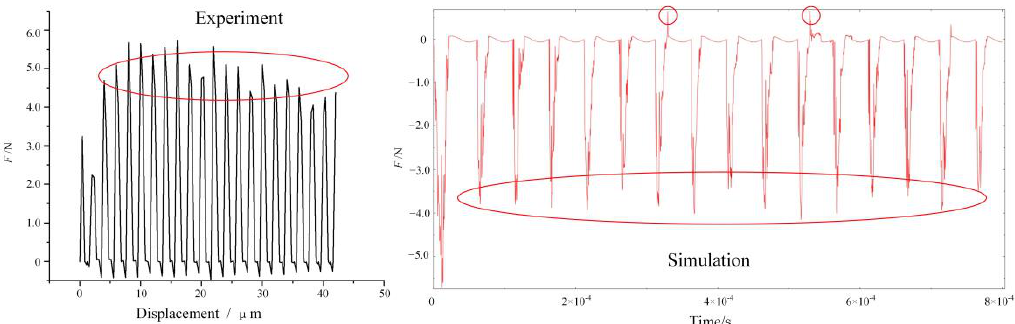
( b ) Figure 9. Three-dimensional surface morphology of UEVC workpiece. ( a ) The feed rate is 20 μm/r; ( b ) the feed rate is 25 μm/r.